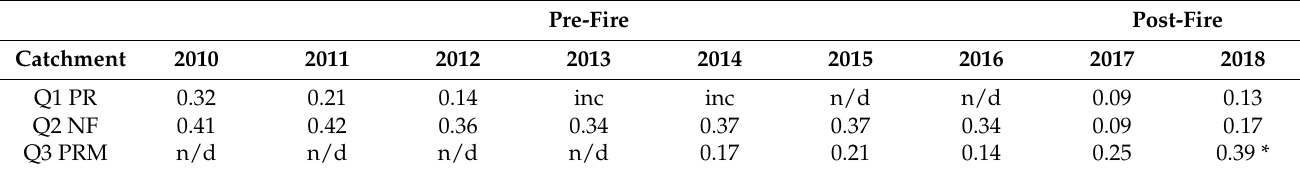
Table 3. Annual runoff coefficients pre- and post-fire (January